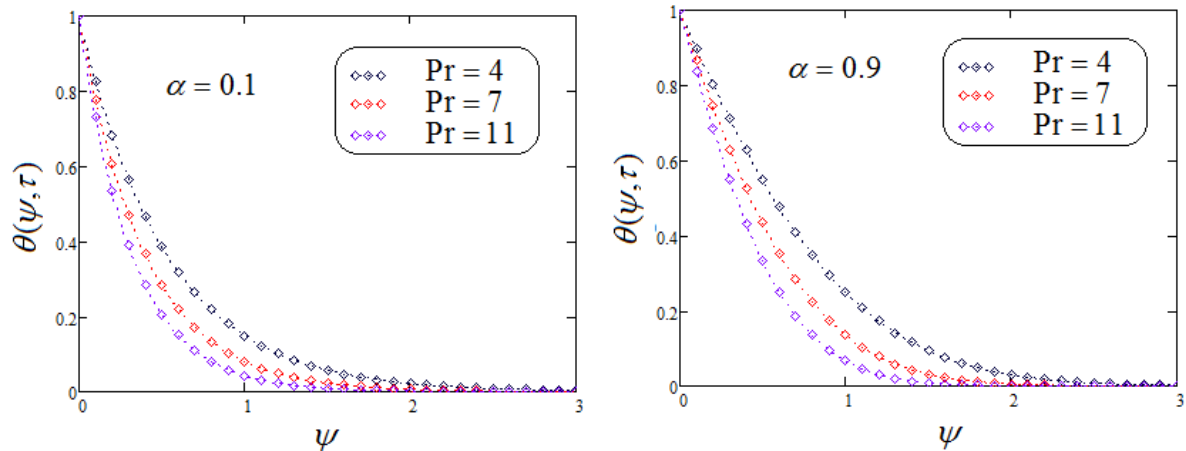
Figure 2. Trace of temperature for dissimilar values of Pr